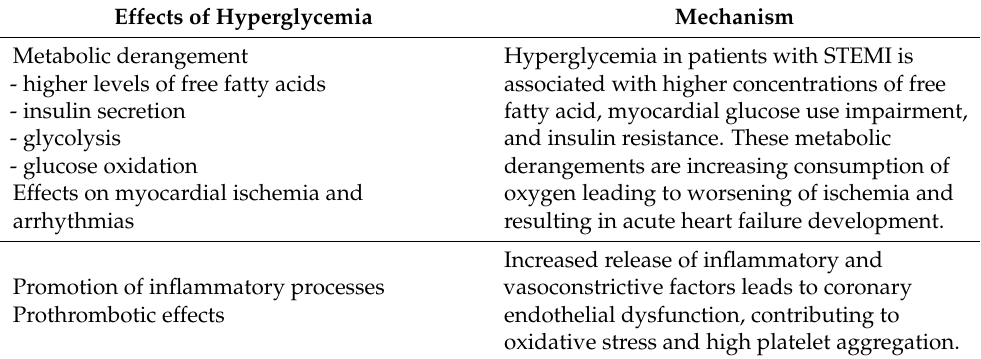
Table 2. Mechanisms of effects of hyperglycemia on heart in